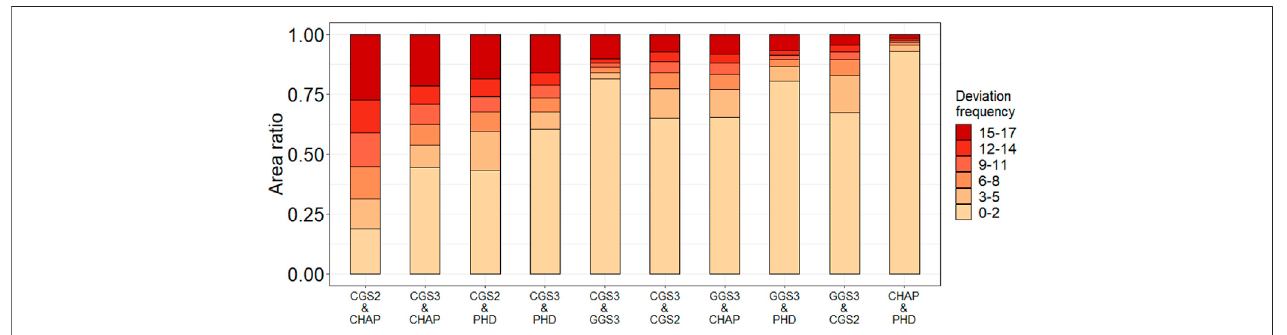
FIGURE 9 | Areas with signi fi cant differences both in PM 2.5 concentration and premature deaths.